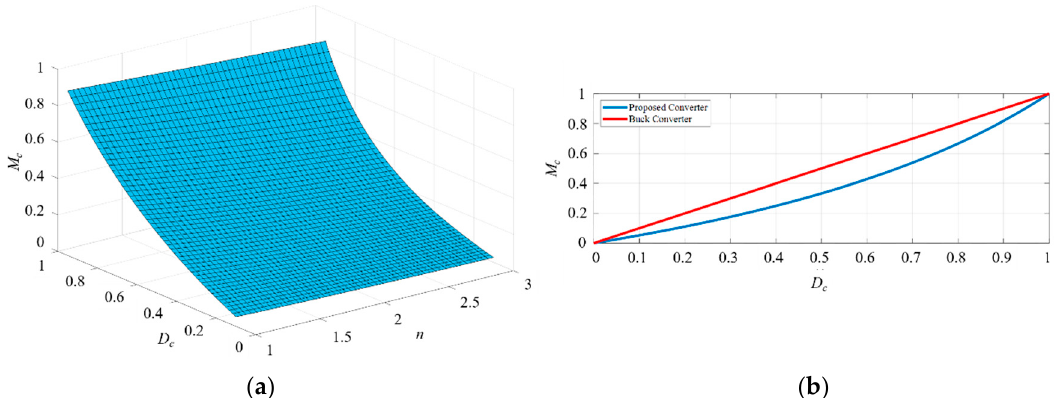
Figure 7. Converter characteristics in charge mode: ( a ) relationship diagram of M c , D c , and n ; ( b ) relationship diagram of M c and D c ( n = 1).